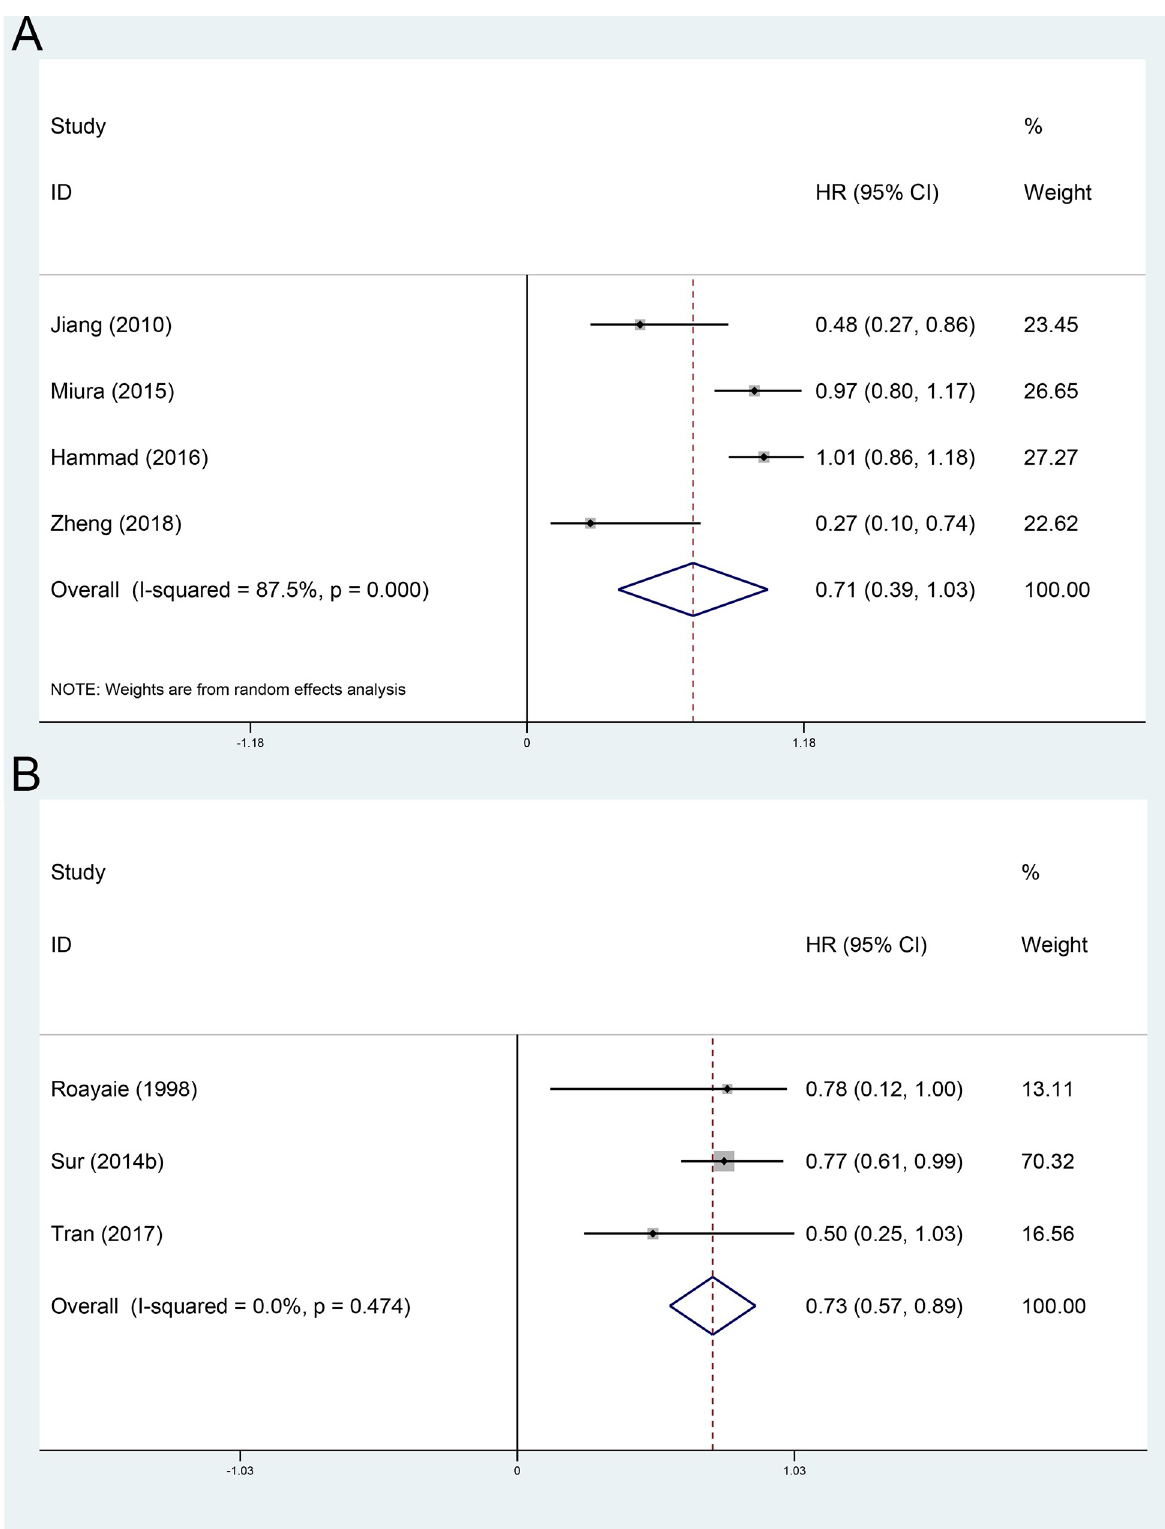
Fig 5. Subgroup analysis of OS stratified by adjuvant radiotherapy and chemoradiotherapy. A, adjuvant radiotherapy; B, adjuvant chemoradiotherapy.